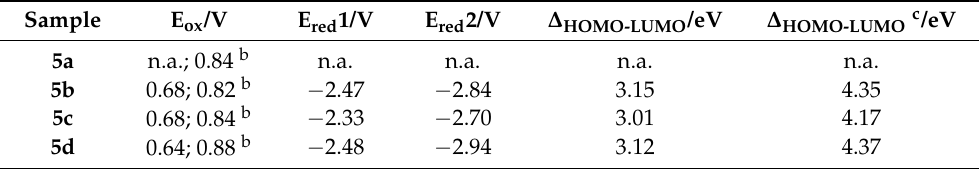
Table 4. Electrochemical properties of complexes reported versus Fc/Fc+ a